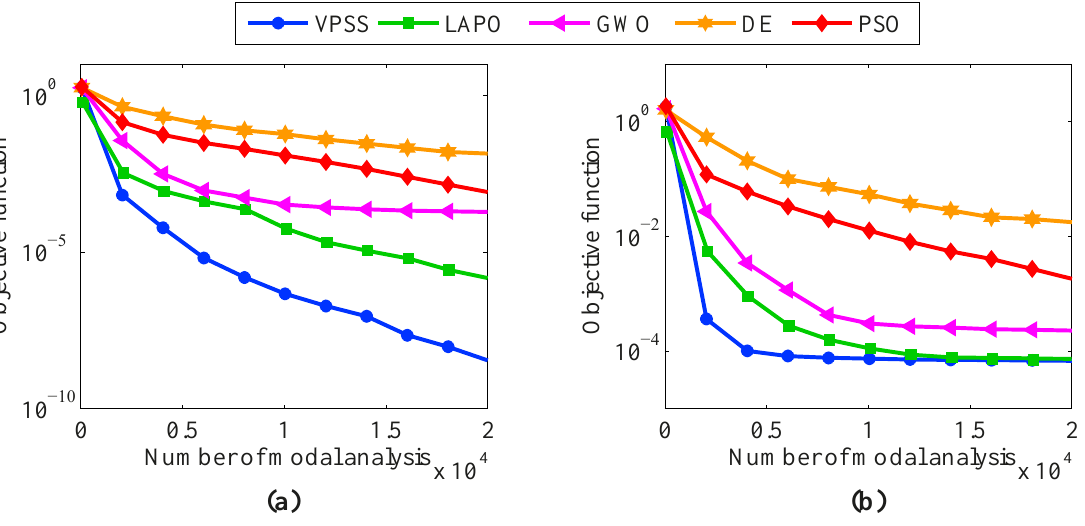
Figure 13. Convergence histories of mean objective function values of VPSS, LAPO, GWO, DE, and PSO for the two-bay three-story frame in the ( a ) noise-free condition and ( b ) noisy condition.